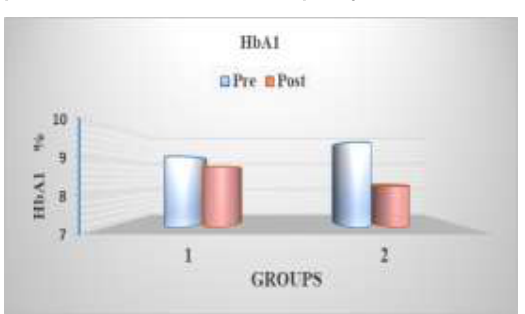
Figure 2. Effect of treatment on FBG level in patients with diabetic neuropathy .